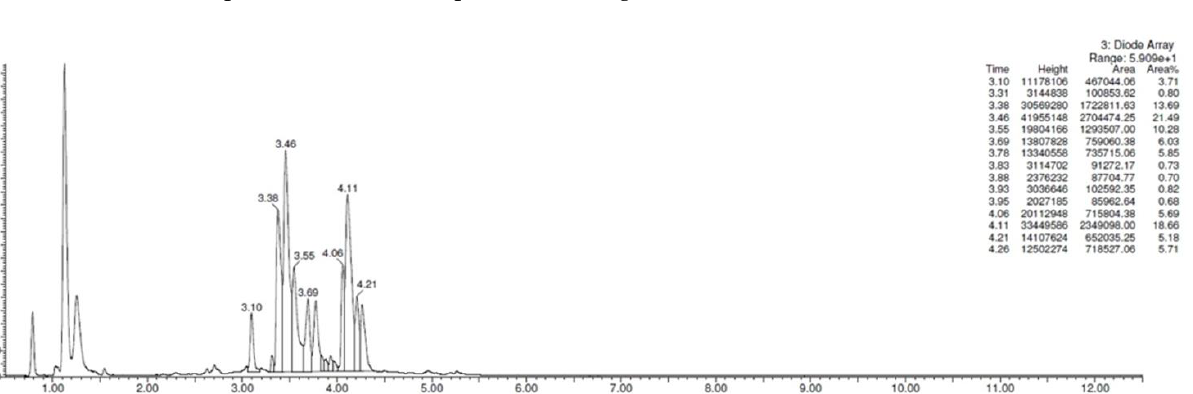
so far. In turn, K-DP1, K-DP2 and K-DP5 were previously detected after degradation of KETO under UV/VIS light over the pH range of 3–10 [18]. Taking all this into account, we